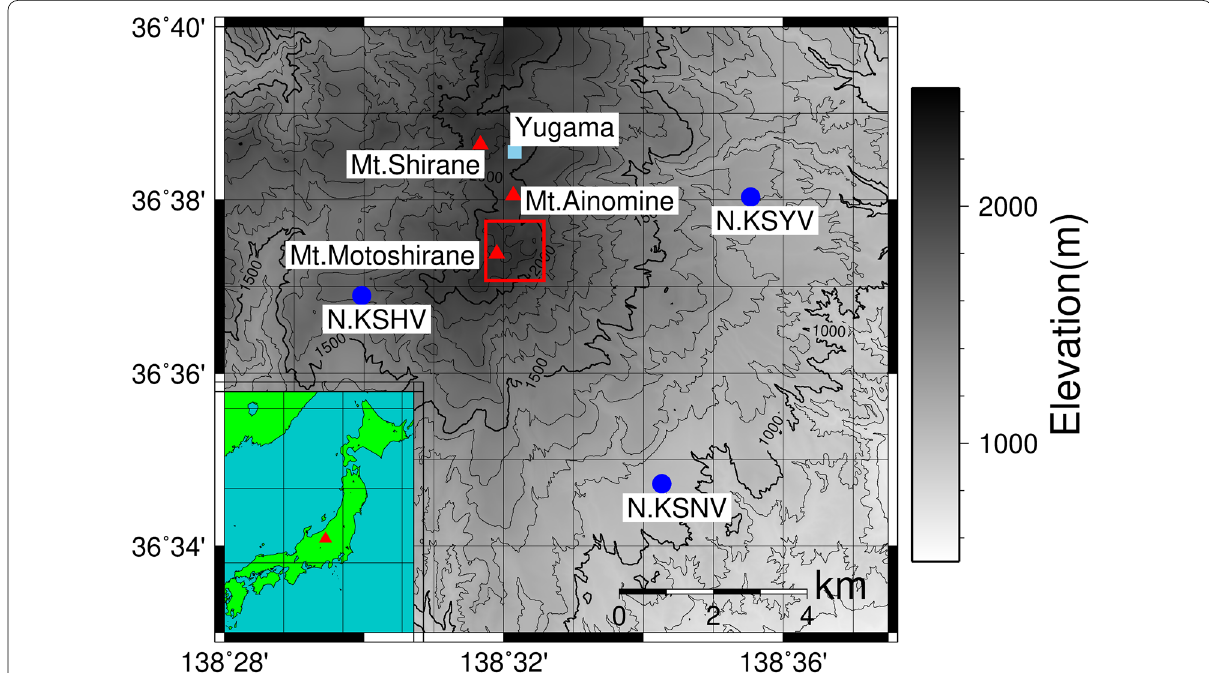
Fig. 1 Station network around Mount Motoshirane. The blue circles represent the Fundamental Volcano Observation Network (V-net) stations operated by the National Research Institute for Earth Science and Disaster Resilience (NIED). The triangles and the blue square represent the summits and a recently active crater lake, respectively. The red square indicates the region depicted in Fig. 2. The inset indicates the location of Mount Kusatsu–Shirane at a regional